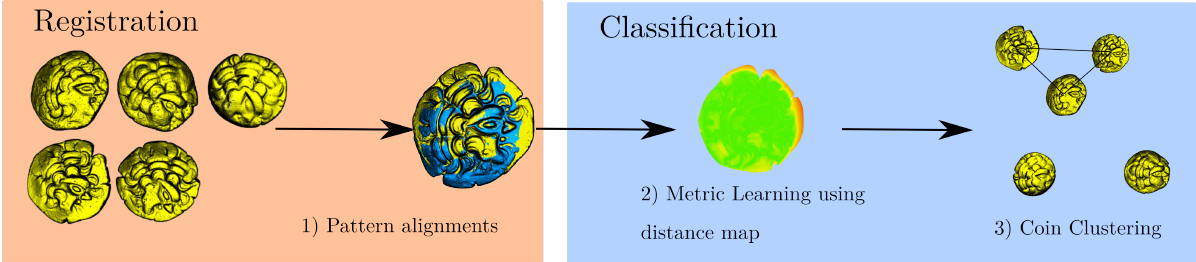
Figure 3. Pipeline of the method. First we perform registration to align patterns, then we compute a point to point distance map and we use machine learning to discriminate similar patterns from different patterns. Then we can group coins with similar patterns and coins with different patterns. need the right matches to compute the correct